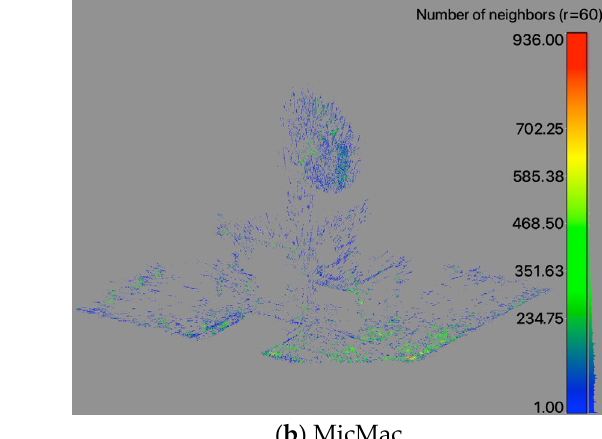
( b ) MicMac Figure 17. Histogram of the density evaluation of a bigger shift on the reconstruction in CloudCompare. The influence of the combined feature detector operators is visible over the different reconstruction models and its comparison to the MicMac models is presented. The edges are locations of higher point density. The main proportion of the points is located within the first half of the spectrum. However, our study achieves a small, but clearly visible proportion within the higher point density spectrum of the histogram. The reconstruc- tion is achieved with only two images, while MicMac needs many more images to re- construct the point cloud.